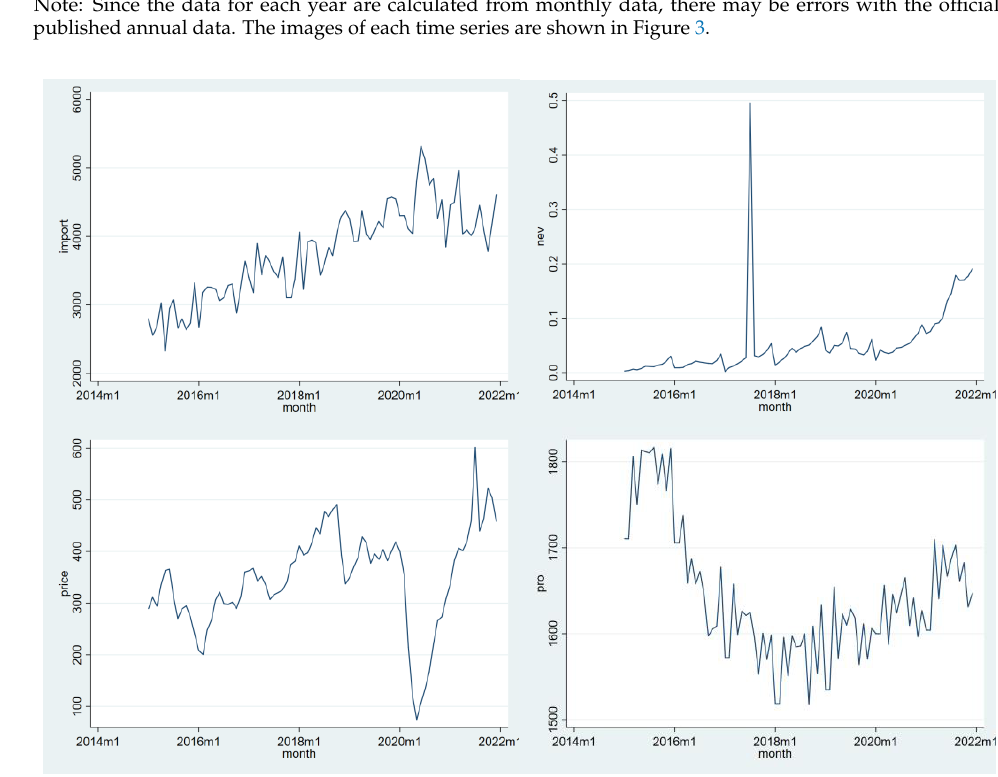
Figure 3. Images of each time